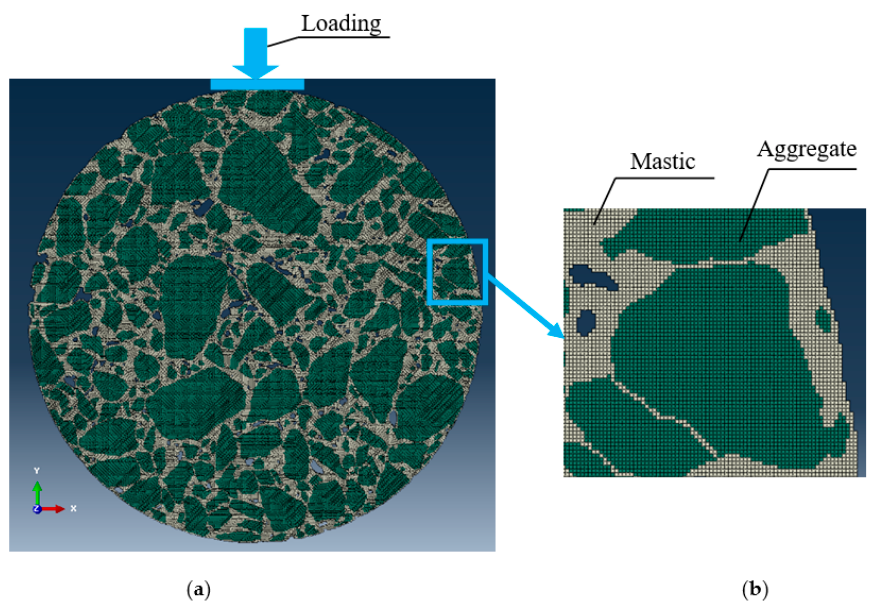
Figure 9. Pixel-based numerical model of HMA mixture (AC-20): ( a ) the whole model; and ( b ) the local graph.